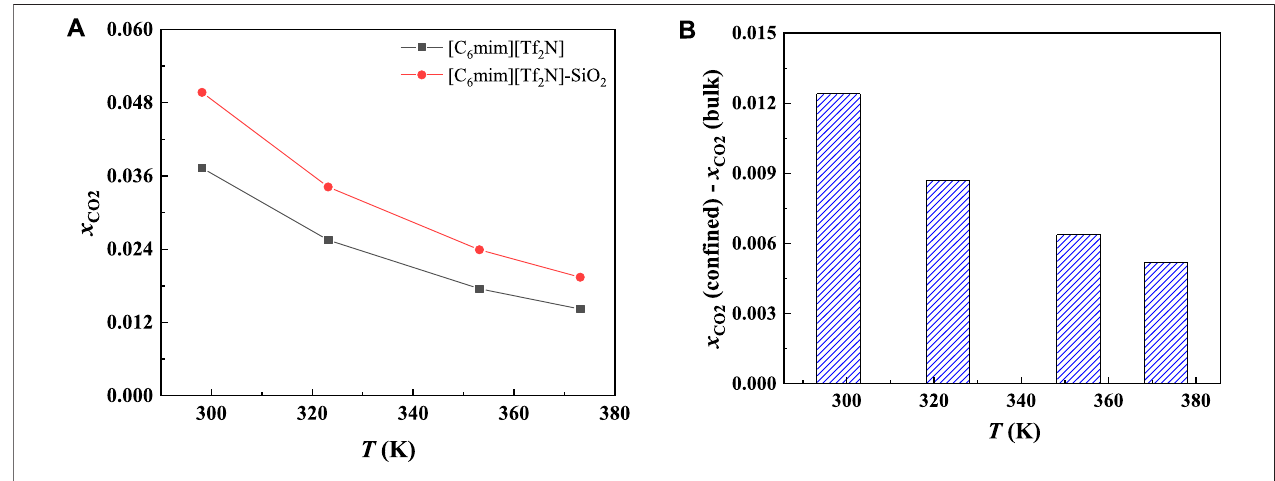
FIGURE 4 | Calculated CO 2 solubility (A) and additional solubilities (B) of ILs con fi ned in 25 Å slit-shaped pore at 1 bar and different temperatures.